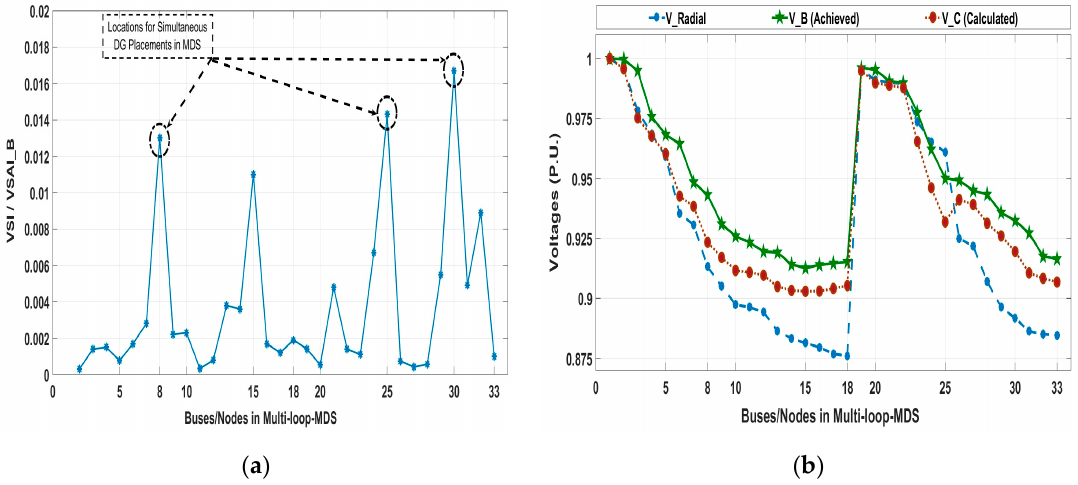
Figure 4. Base case without DG (Steps 1–4) ( a ) VSAI_B projection without DG in 33-bus MDS; ( b ) Achieved ( V_C ) and calculated ( V_C ) Voltage profiles without DGs in 33-Bus MDS .